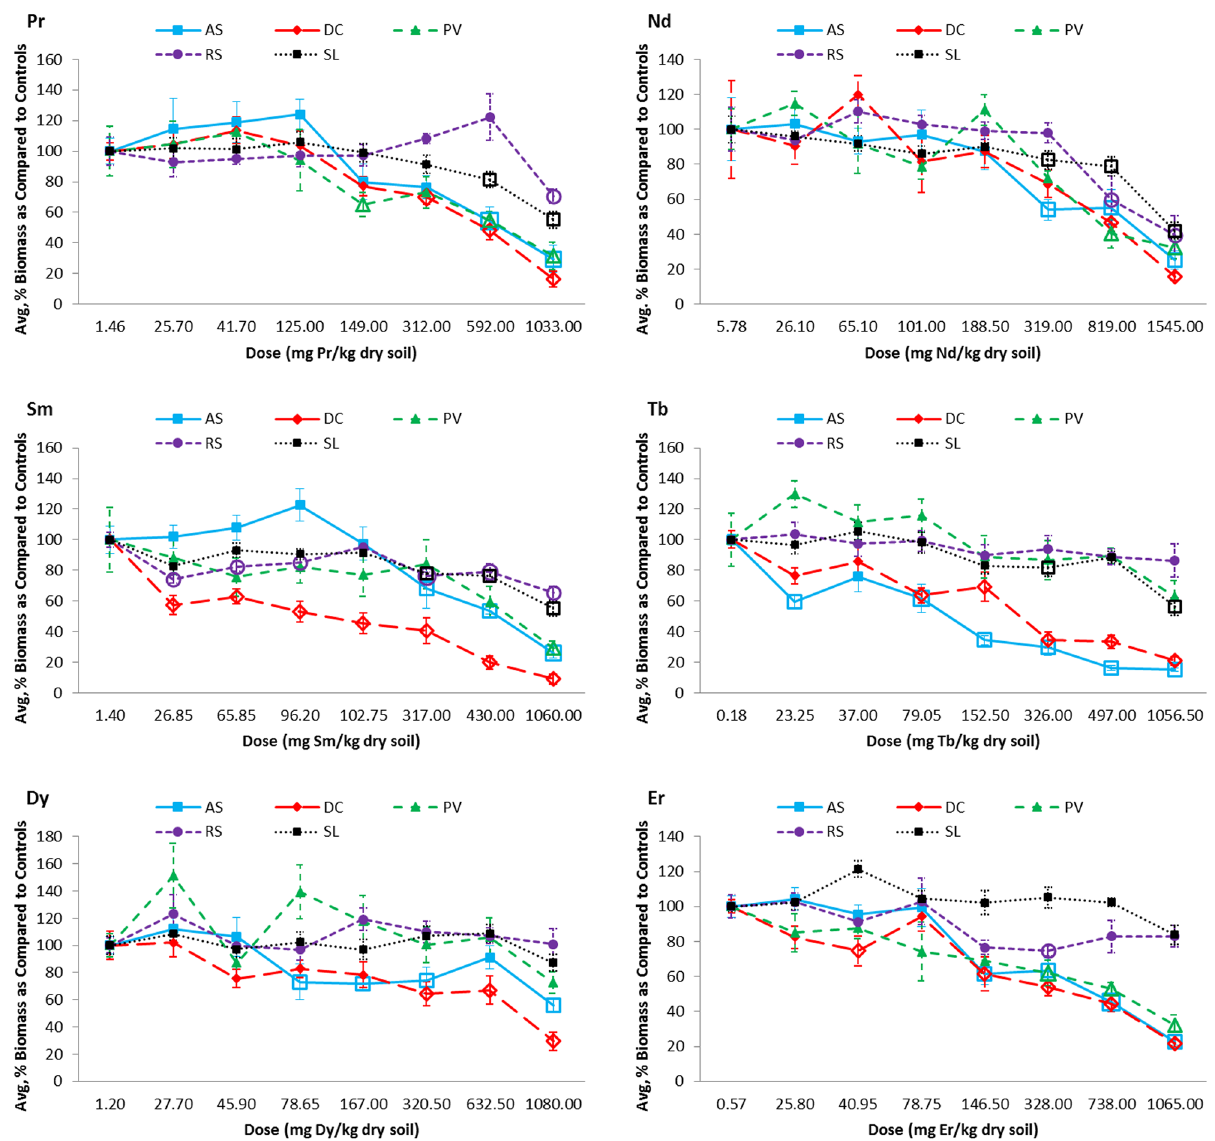
Fig 1. Dose-response curves for the aboveground, shoot (leaves and stems) biomass of all five tested plant species grown in rare earth element (REE) contaminated soils. Biomass is presented as the average percent biomass as compared to the controls, such that the controls always have a mean of 100%. Doses that were found to be significantly, negatively different from the controls based on statistical analyses using ANOVA (Dunnett's one-way post hoc comparison) or the Kruskal-Wallis test (Conover-Inman post hoc comparisons) are indicated with open bullets. Error bars represent standard error. AS = Asclepias syriaca , DC = Desmodium canadense , PV = Panicum virgatum , RS = Raphanus sativus and SL = Solanum lycopersicum